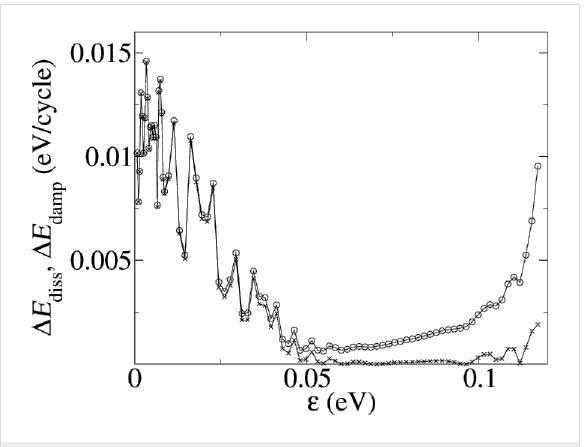
Figure 11: Damping rate (upper curve) and dissipation rate (lower curve) as a function of the strength ε of the short range part of the potential. Below 0.05 eV the cantilever damping is due to adhesion hysteresis. Above, it is mainly due to the transfer of energy from the normal into the lateral oscillation